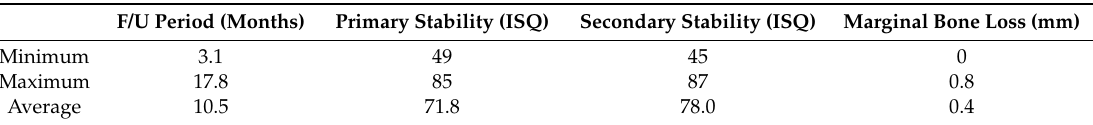
Table 1. Clinical findings of the installed implants.